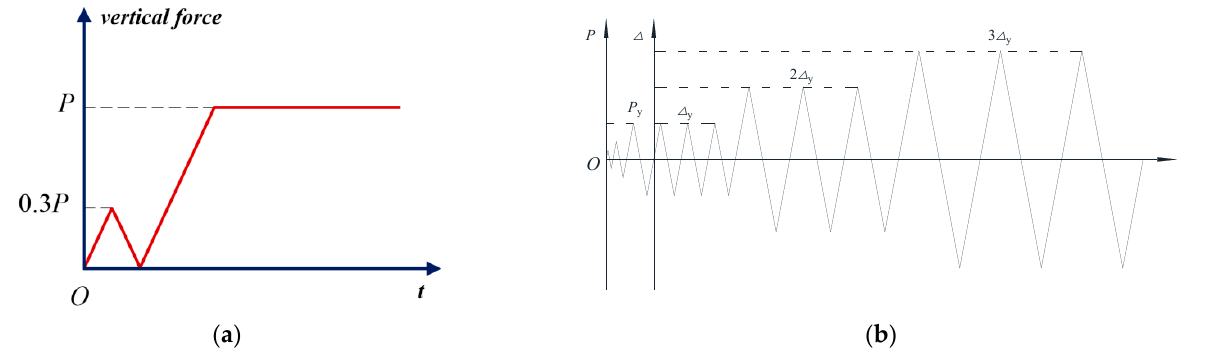
Figure 8. Loading pattern of the test. ( a ) Vertical loading programs. ( b ) Horizontal loading programs.